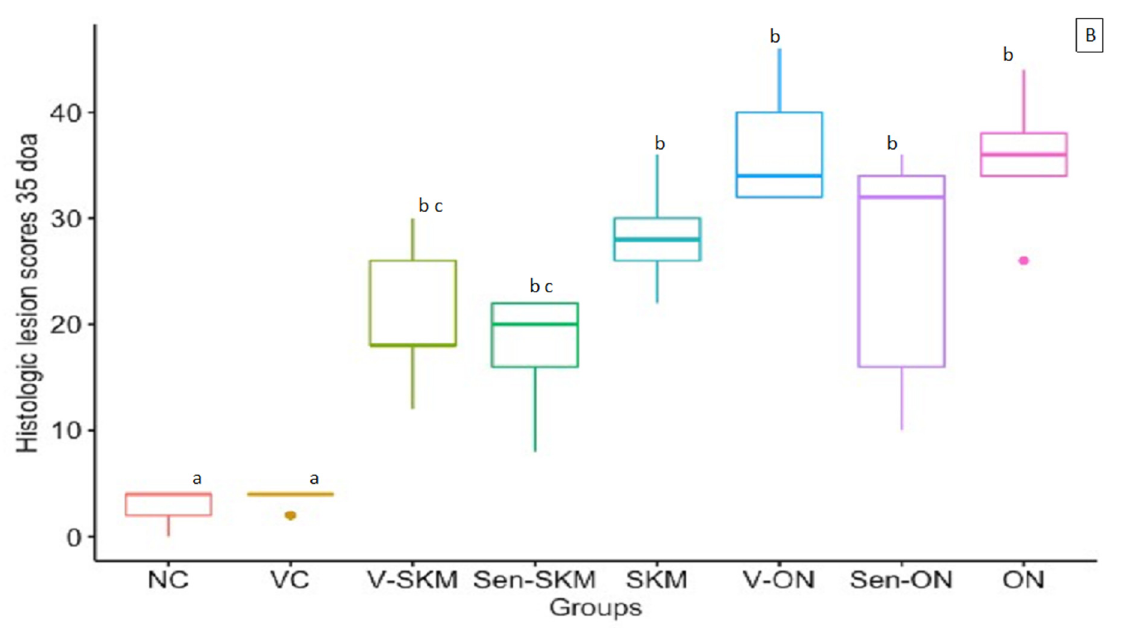
Figure 3. Histologic lesion scores in tendons of birds from respective groups at ( A ) 28 doa; ( B ) 35 doa. Box plots with different letters have significant differences at p < 0.05.